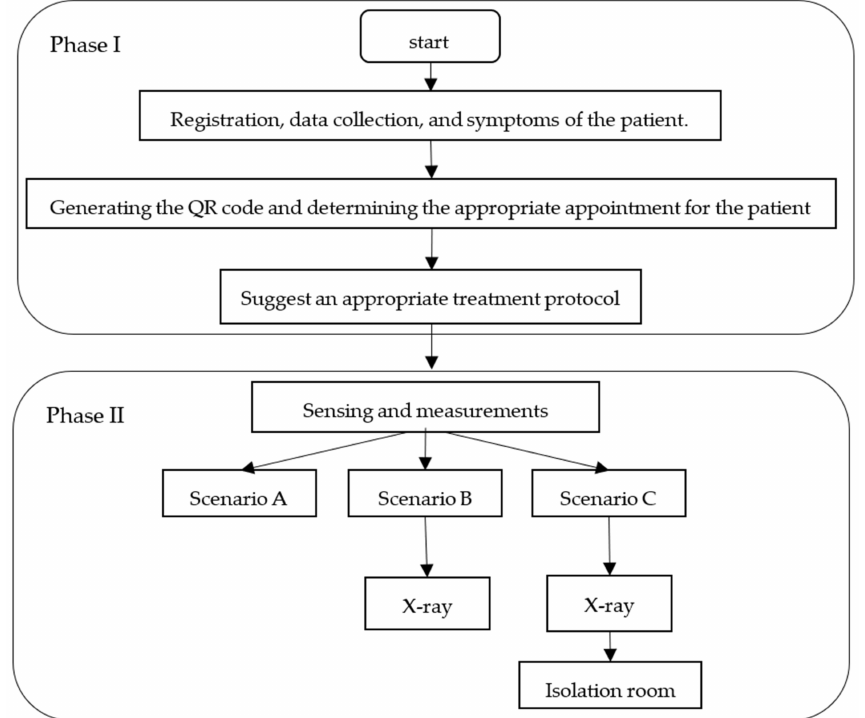
Figure 3. The block diagram of phases of the smart